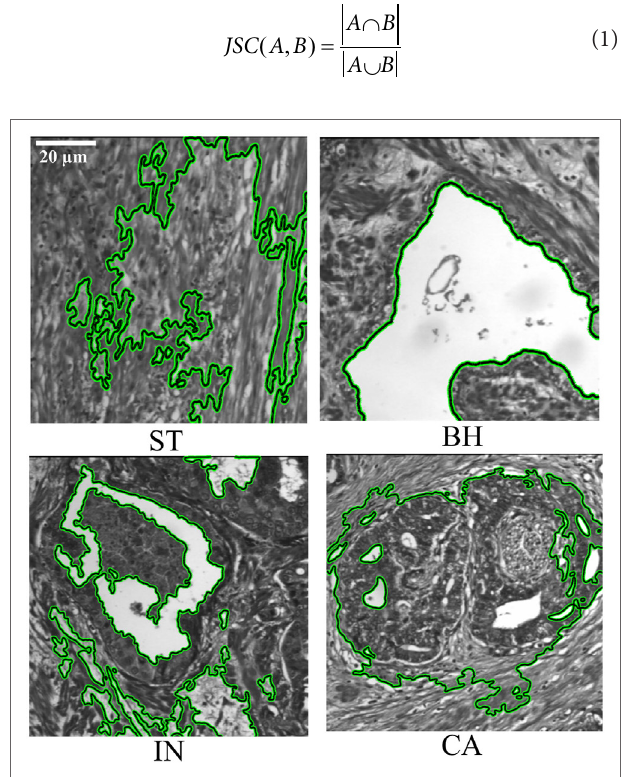
FigUre 3 | Segmentation of pathology tissue (PTs) by the active contour model applied on histopathological 2D multispectral digital slide images ( × 40 objective magnification; scale bars = 20 µm) with four PT types (i.e., stroma, benign hyperplasia, intraepithelial neoplasia,